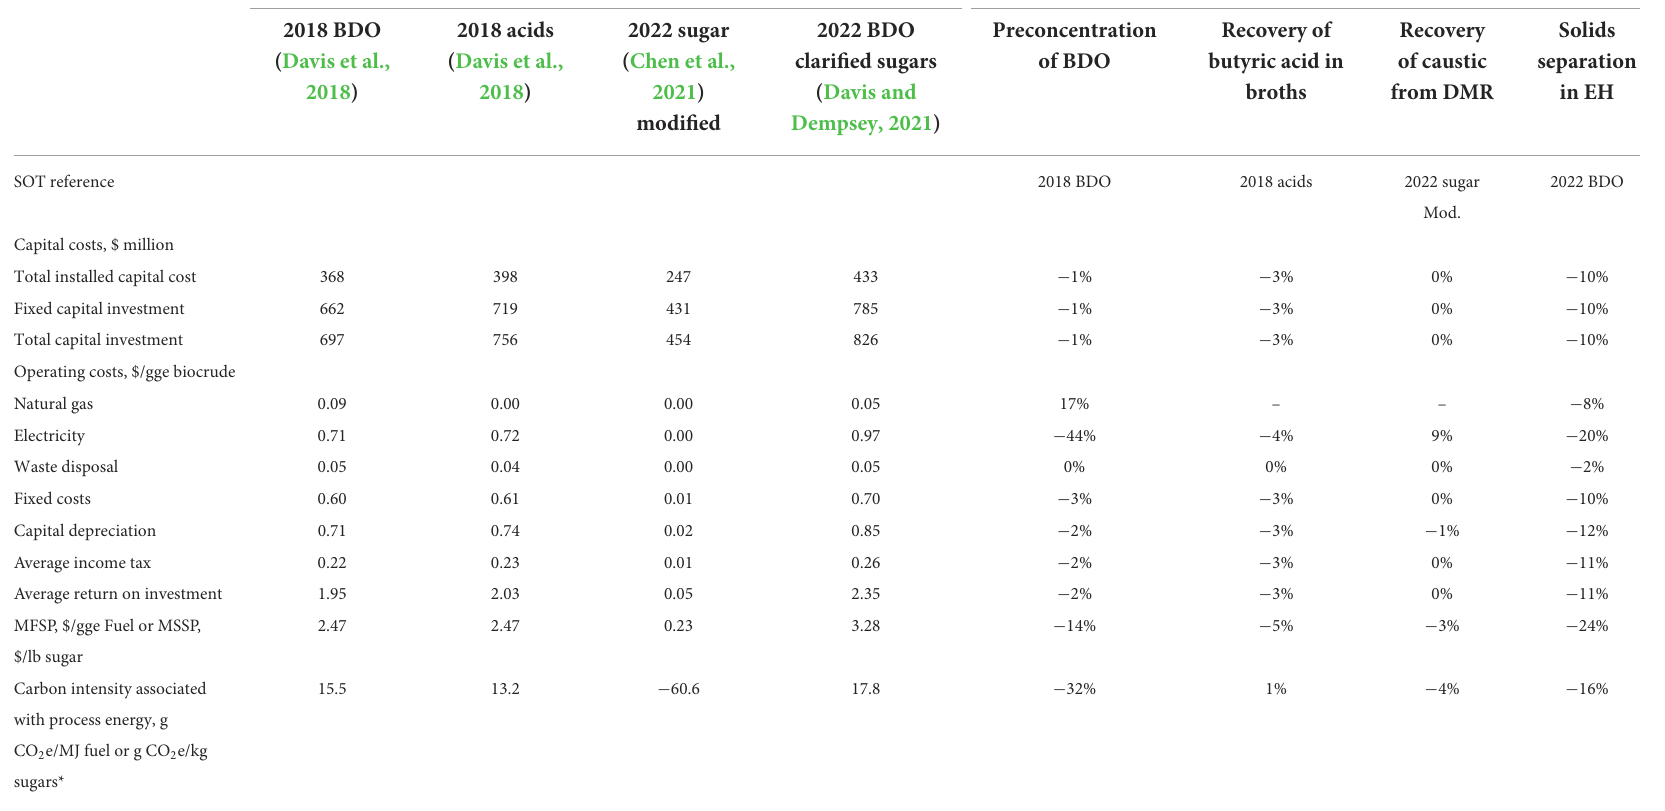
TABLE 3 Techno-economic estimates for the biochemical separation challenge streams using the “ideal” separator